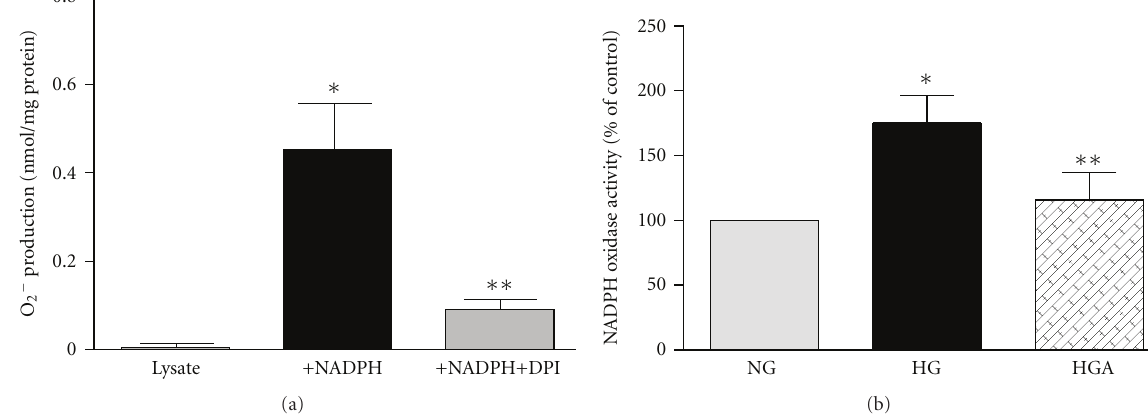
Figure 2: Apocynin reverses glucose-induced NADPH oxidase activity . (a) Cultured bovine retinal capillary pericytes express active NADPH oxidase. The activity was determined by cytochrome c reduction. Lysate (25 μ g protein) was added to 250 μ M cytochrome c in a 96- well multiwell plate and incubated for 120min, either in the presence or absence of NADPH (100 μ M) or NADPH oxidase inhibitor or flavoprotein inhibitor, diphenyleneiodonium (DPI, 100 μ M). The reduction of cytochrome c was measured by reading absorbance at 550nm (SpectraMax 190). Superoxide (O 2 − ) production innmol/mg protein was calculated from absorbance of samples and the extinction coe ffi cient for change of ferricytochrome c to ferrocytochrome c of 21mmol/l/cm. Data are presented as mean ± SEM of 4–6 separate experiments. ∗ P < . 001 versus lysate alone, ∗∗ P < . 01 versus lysate with NADPH. (b) Exposure to high glucose for 4 days increases NADPH oxidase which is significantly reversed by the addition of apocynin. Confluent cultures of BRP in 30mm 2 dishes were exposed to normal glucose (NG, 5.6 mM) and high glucose (HG, 25mM) with and without 500 μ M apocynin (HGA) for 4 days. After incubation, the cells were washed twice with ice-cold PBS; lysed, and NADPH-dependent O 2 − production was measured by DPI-inhibitable cytochrome c reduction assay. Data are presented as mean ± SEM of 4 separate experiments. ∗ P < . 05 versus HG. ∗∗ P < . 013 versus HG.